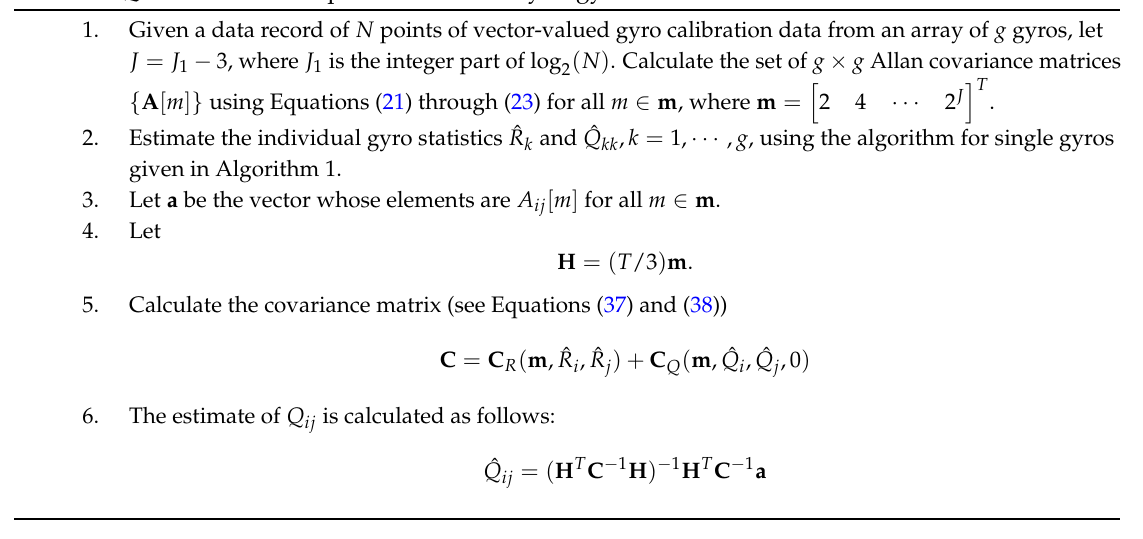
Algorithm 2: An algorithm for estimating the off-diagonal terms, Q ij , of the spectral density matrix Q for the drift components of an array of